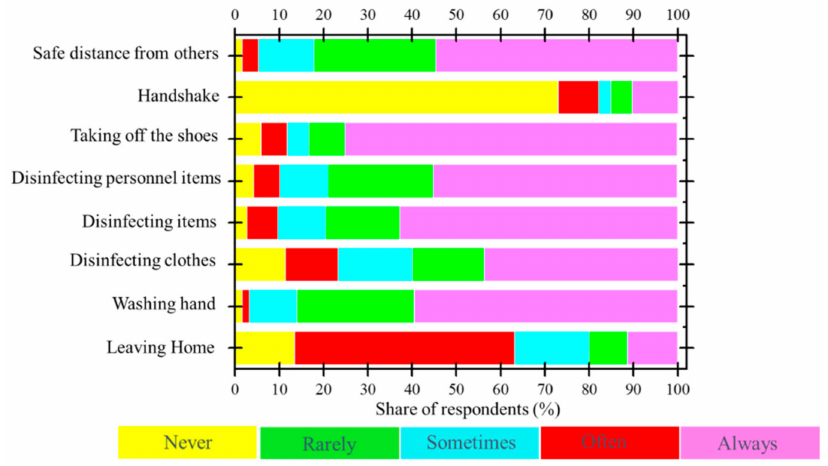
Figure 4. Habits and behaviors during the